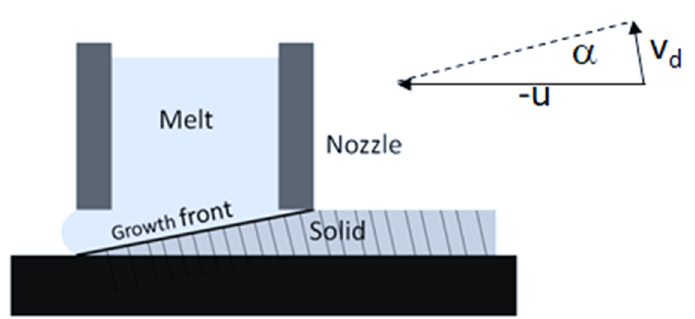
Figure 5. Schematic illustration of the growth front and the related declination of columnar crystals in melt spinning (u: wheel surface speed; v d : dendritic growth velocity; α = inclination of columnar dendritic crystals).